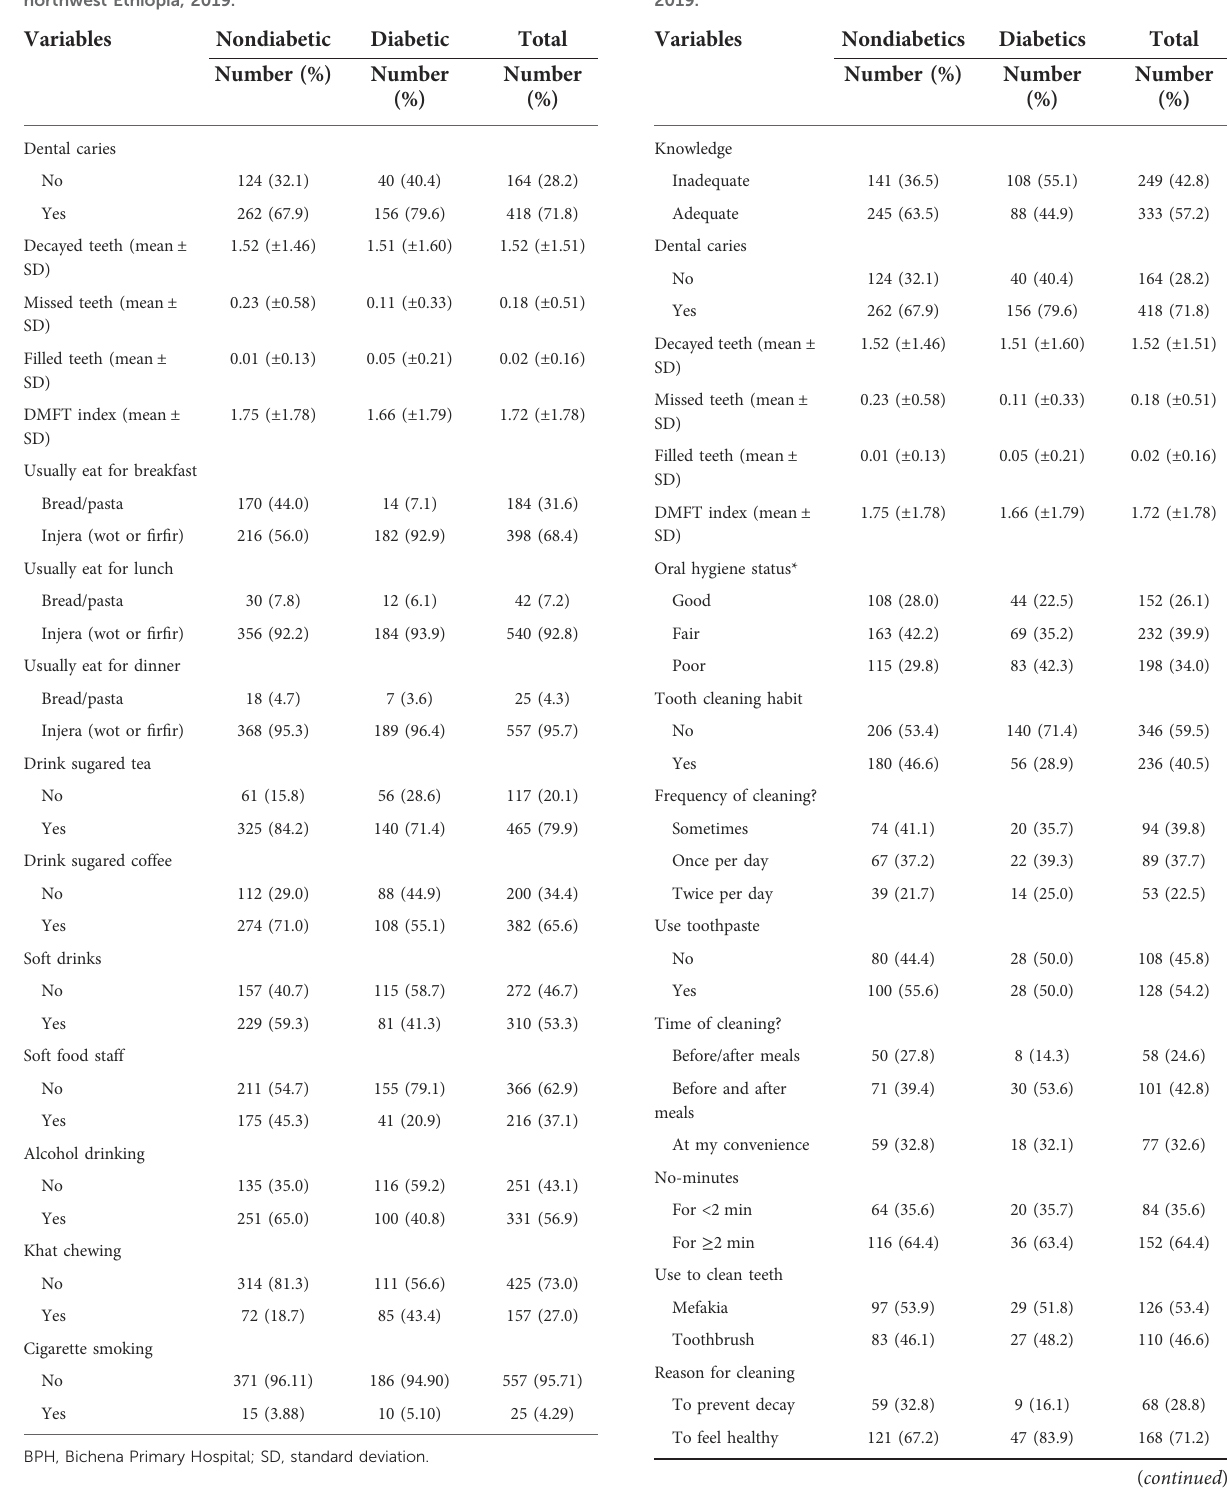
TABLE 2 Lifestyle characteristics and food consumption patterns of study participants attending the outpatient department in BPH, northwest Ethiopia, 2019.